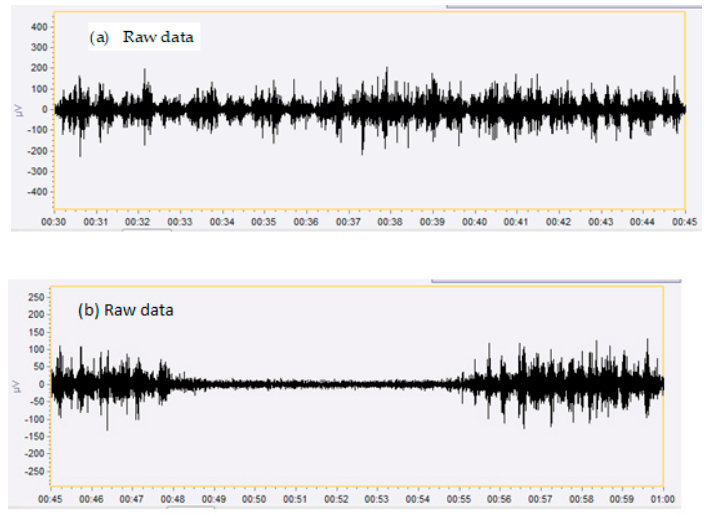
Figure 3. (a) A sample of the gross surface electromyography signal register (RAW) of the suprahyoid musculature of infants with lingual frenulum attachment in the middle third and sublingual caruncles and ( b ) lingual frenulum attachment at the apex and lower alveolar